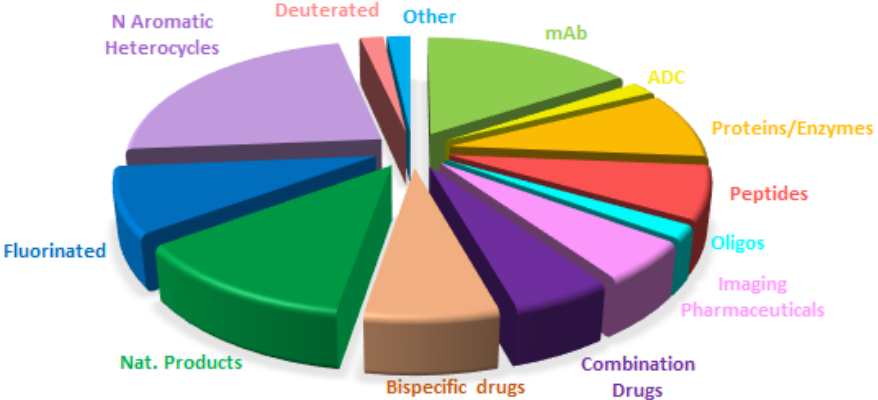
Figure 14. Drugs approved by the FDA in 2021 classified on the basis of chemical structure (drugs can belong to more than a class) Adapted with permission from Ref. [1]. Copyright 2022, copyright MDPI.